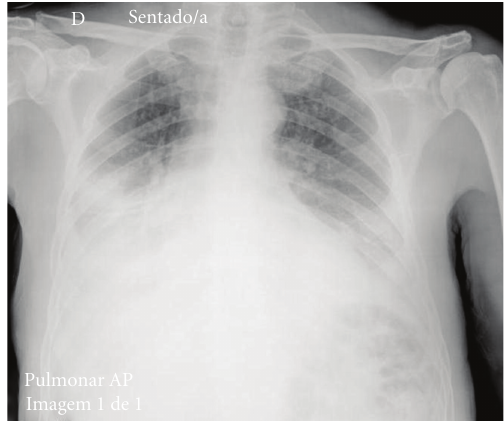
Figure 1: Chest X-ray on the day of admission.